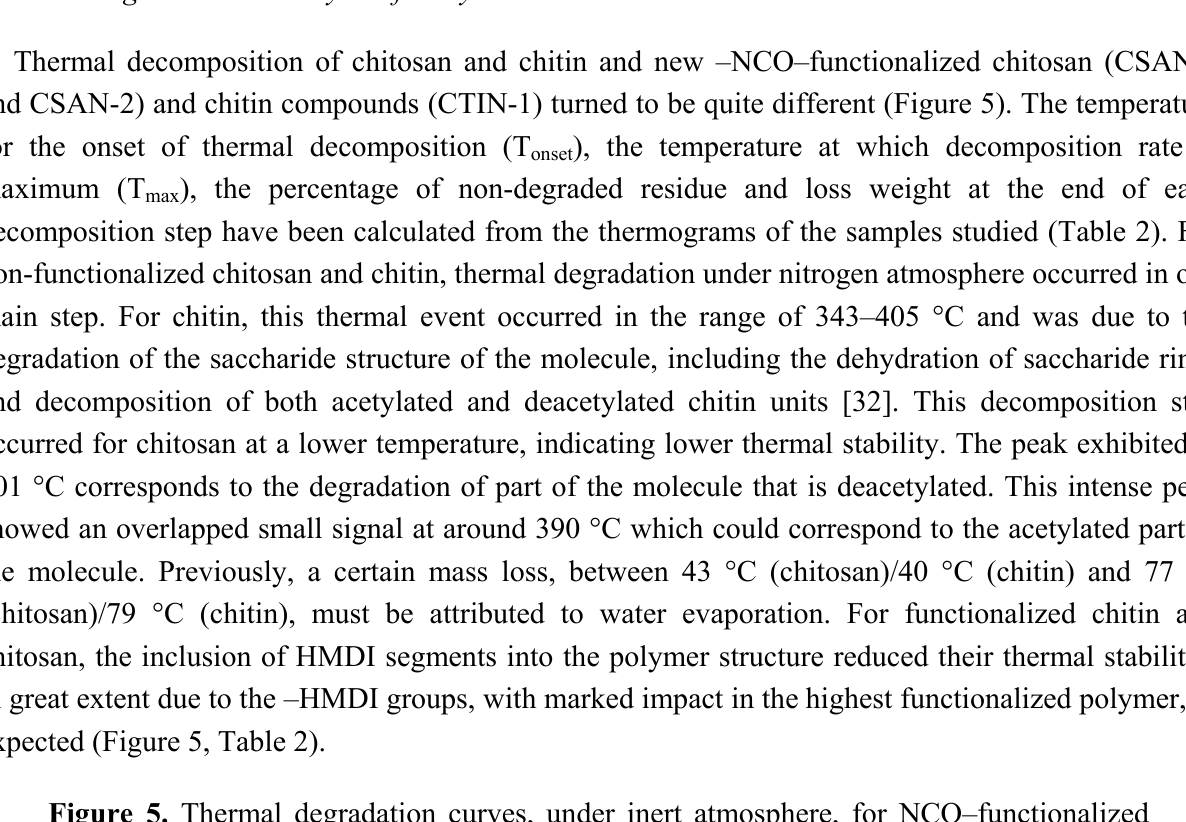
Figure 5. Thermal degradation curves, under inert atmosphere, for NCO–functionalized chitosans and chitins and starting